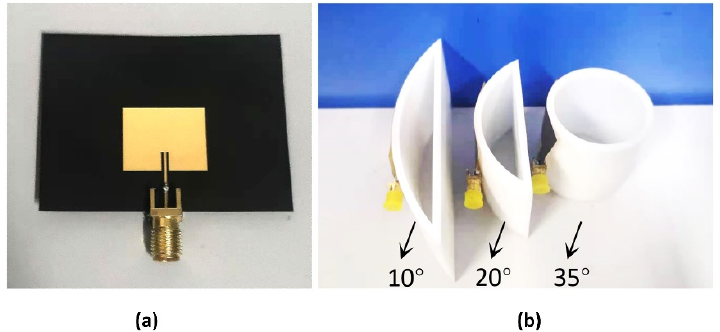
8 of 10 Table 1. Equivalent circuit lumped element parameters with different E-plane bending angles. Circuit Parameters